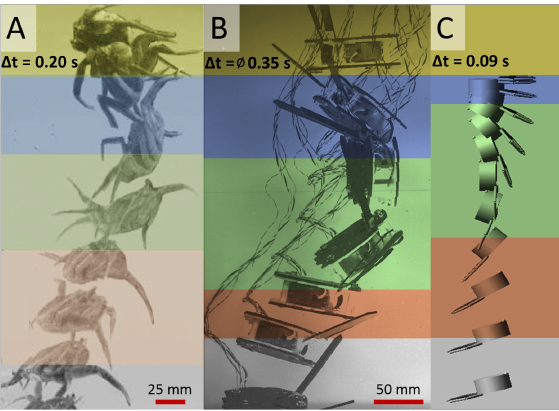
Figure 5. Comparison of characteristic turning phases of ( A ) E. sinensis , ( B ) O-Typus and ( C ) the simulated model. Phases: 1 (yellow), 2a (blue), 2b (green), 3a (orange) and 3b